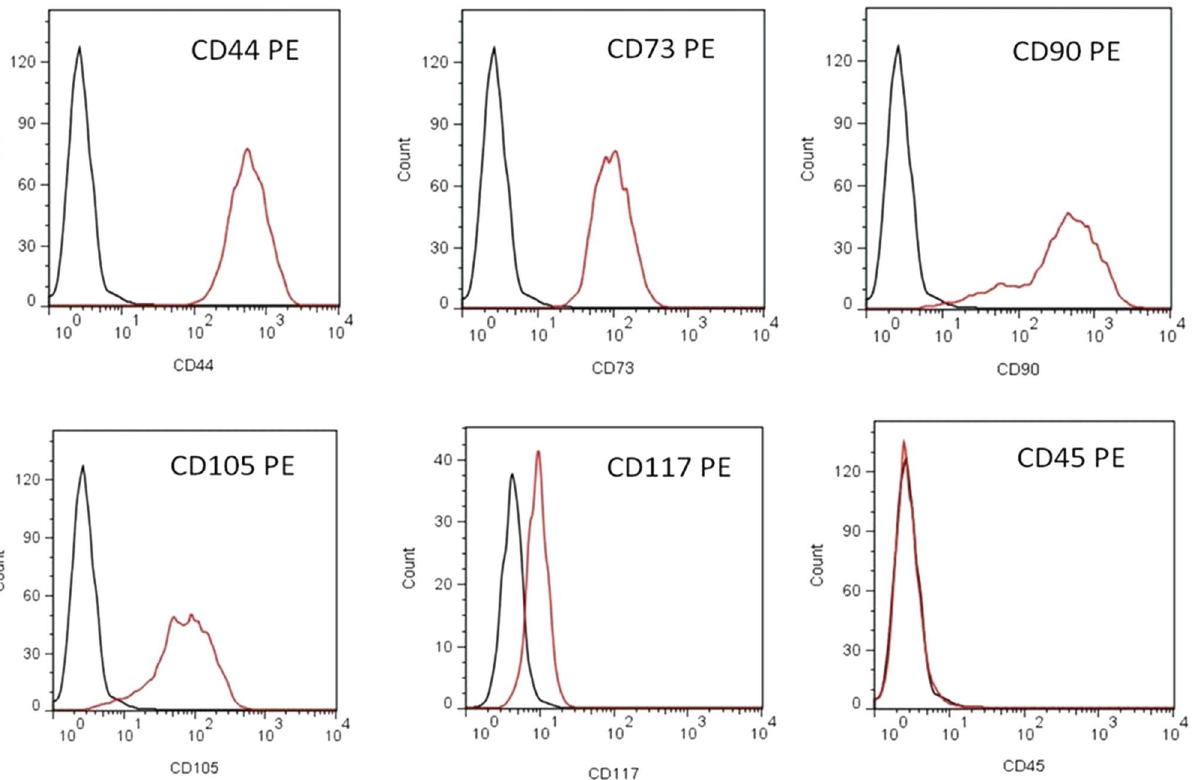
Figure 1. Flow cytometry analysis of surface marker of hAFSC. hAFSCs were positive for CD44, CD73, CD90, CD105 and CD117, markers of MSC, and negative for CD45, a marker of leukocyte. hAFSC human amniotic fluid stem cell, MSC mesenchymal stem cell, PE